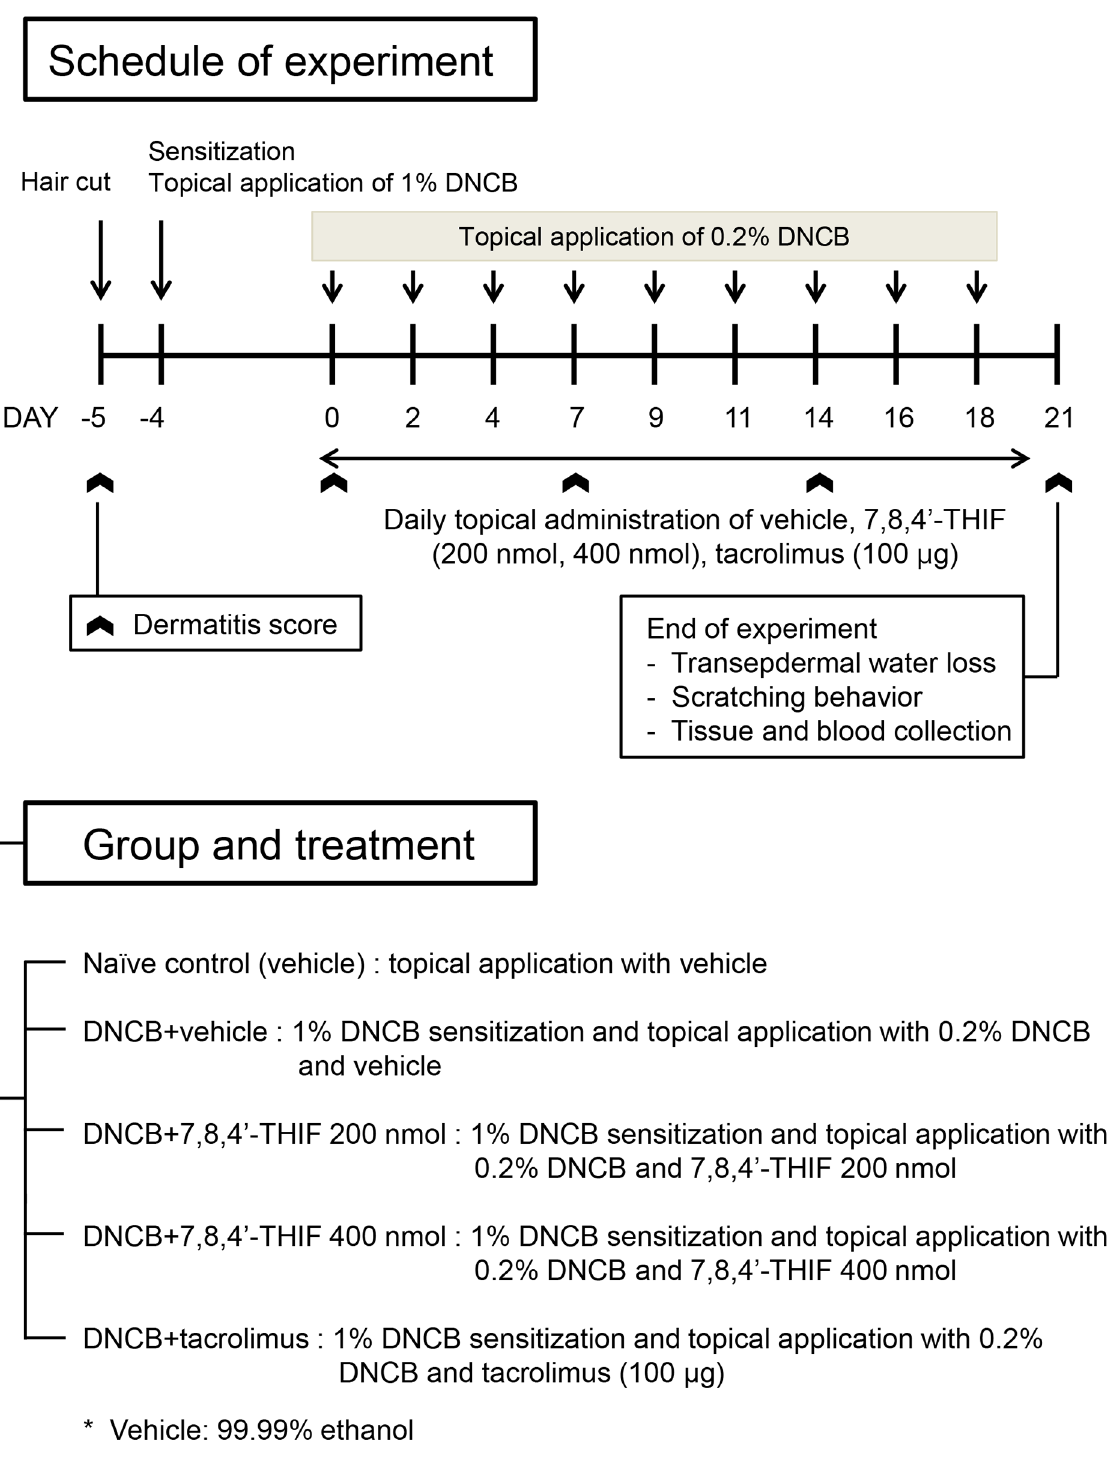
Figure 1. Experimental design. NC/Nga mice were divided into five groups: (1) naı¨ve control (vehicle), (2) DNCB + vehicle, (3) DNCB + 200 nmol 7,8,4 9 -THIF, (4) DNCB + 400 nmol 7,8,4 9 -THIF, and (5) DNCB + tacrolimus. To induce AD-like symptoms, DNCB was topically applied on NC/Nga mice. A day after complete dorsal hair removal, 1% DNCB was applied (day 2 4). Five days after dorsal hair removal, 0.2% DNCB was challenged three times a week for three weeks (day 0–20). 7,8,4 9 -THIF or tacrolimus was topically applied seven times a week for 3 weeks (day 0–20). doi:10.1371/journal.pone.0104938.g001 evaluated dermatitis scores, and measured ear thickness. On day treatment of 7,8,4 9 -THIF or tacrolimus, decreased AD-like 21, the ear and dorsal skins of DNCB-treated NC/Nga mice symptom severity (Fig. 2A). The dermatitis score was gradually showed severe erythema, erosion, and dryness (Fig. 2A). Co- increased in DNCB-treated NC/Nga mice (Fig. 2B). On day 21,